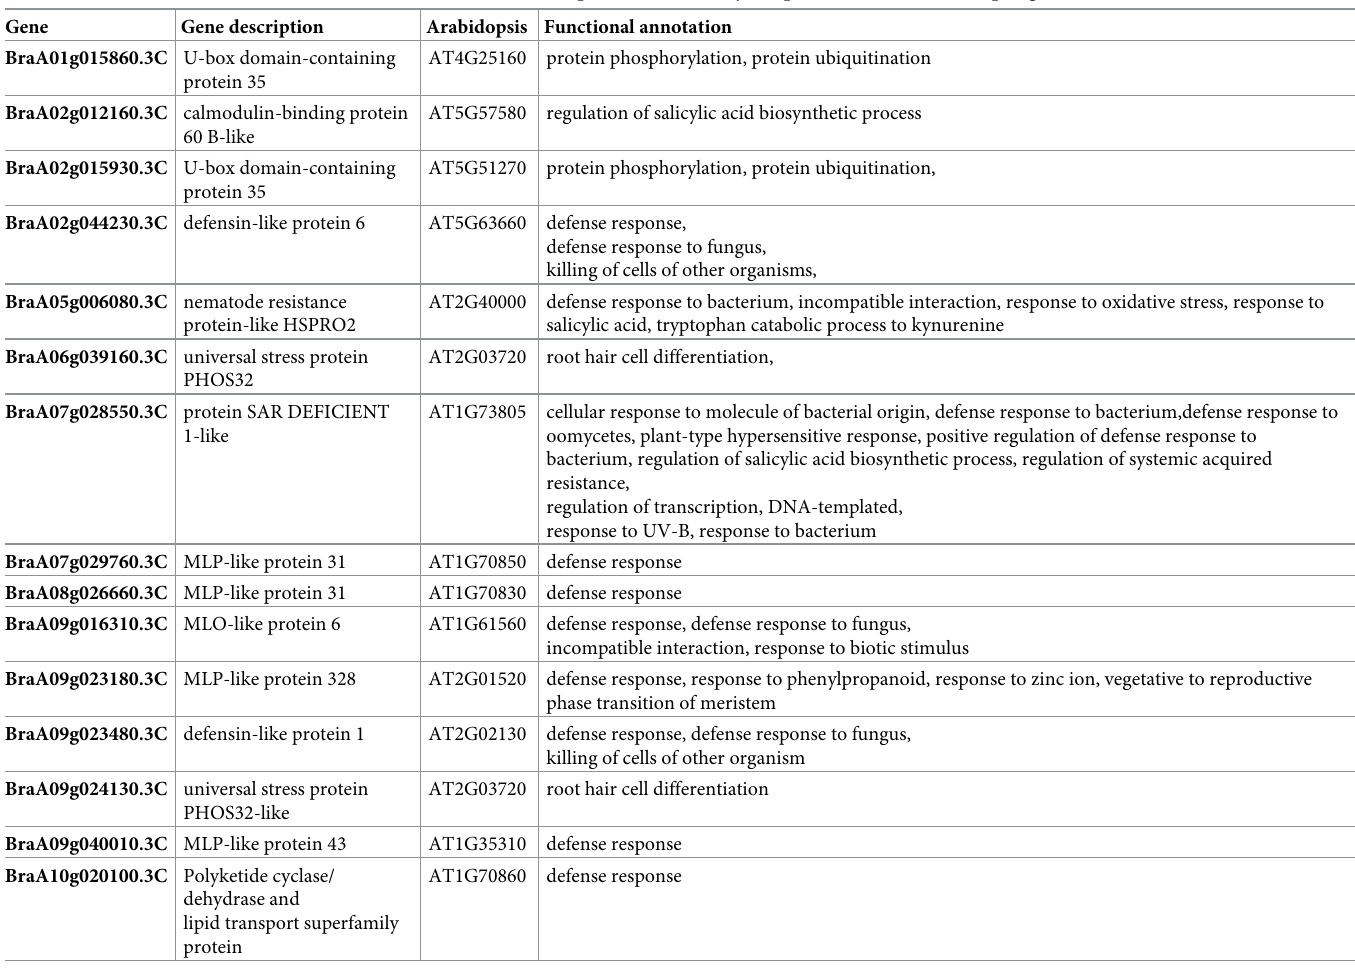
Table 3. Annotation of 15 mRNAs involved in LncRNA-mRNA co-expression network by comparison with the Arabidopsis genome. Gene Gene